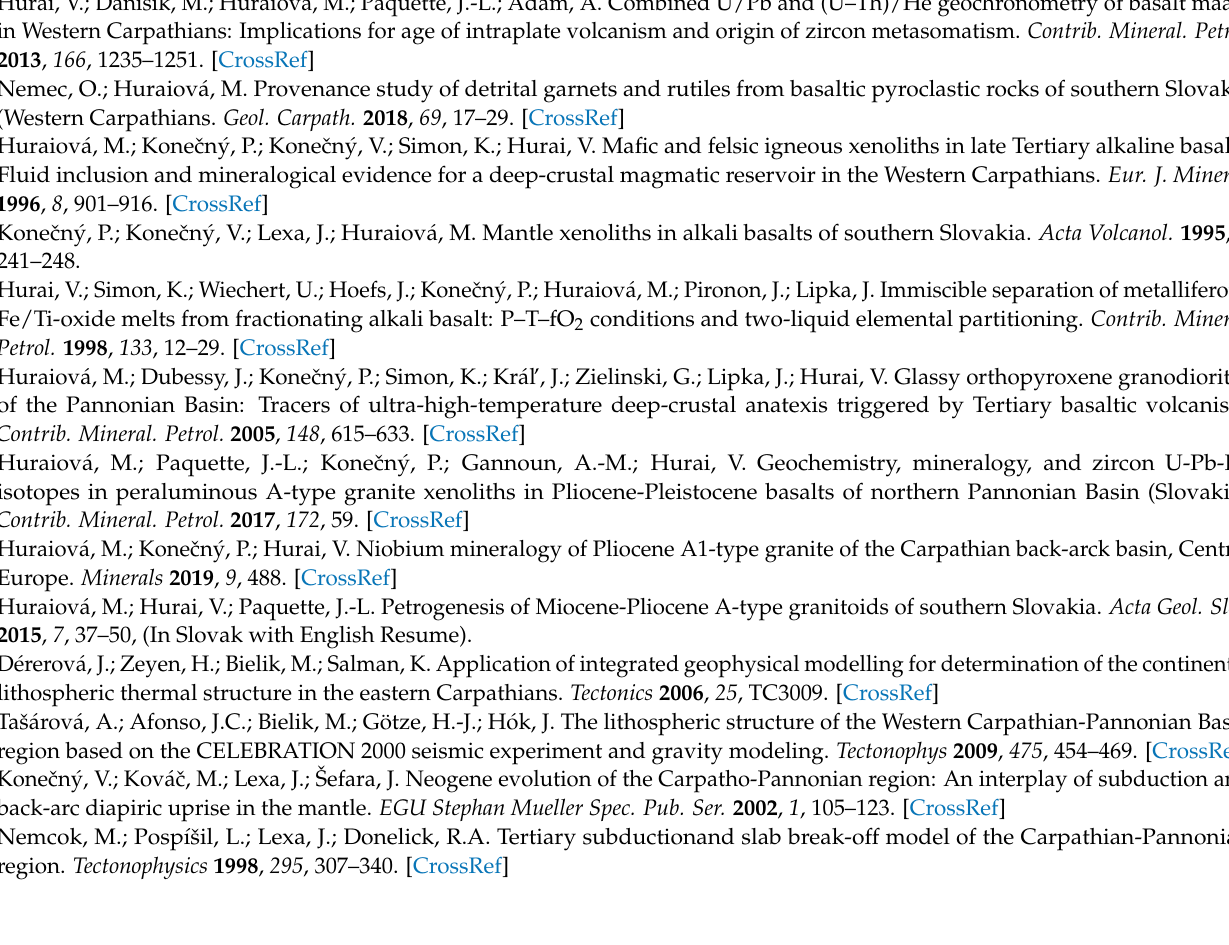
EPMA of silicate glass, Table S6: EPMA of ilmenite and rutile, Table S7: EPMA of apatite, Table S8: EPMA of titanite, Table S9: EPMA of zircon and baddeleyite, Table S10: EPMA of chevkinite, Table S11: EPMA of high-Th yttrium silicates, Table S12: EPMA of low-Th yttrium silicates, Table S13: EPMA of britholite, Table S14: EPMA of rhabdophane, Table S15: EPMA of